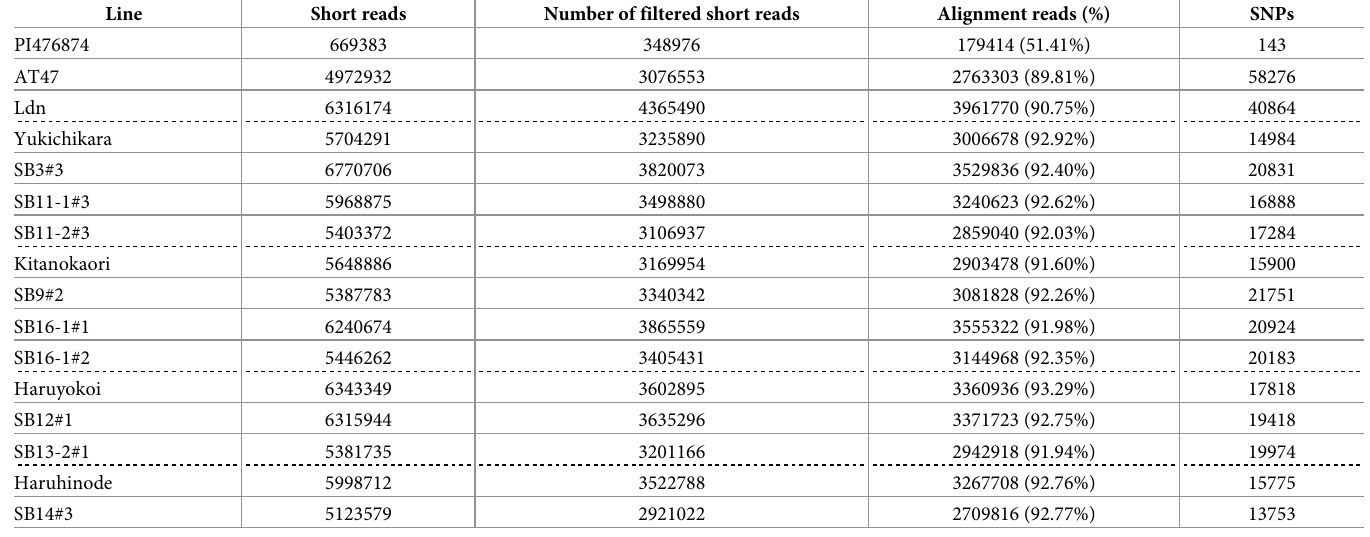
Table 6. Alignments of RNA-seq reads to the CS reference genome and SNP